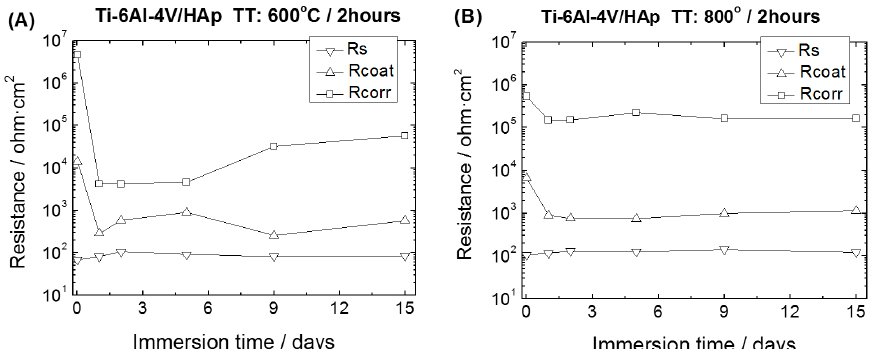
Figure 17. Evolution of the R s , R coat and R corr values with immersion time in SBF of HAp-coatings/Ti6Al4V systems. Thermal Treatments: ( A ) 600 °C/2 h and ( B ) 800 °C/2 h.